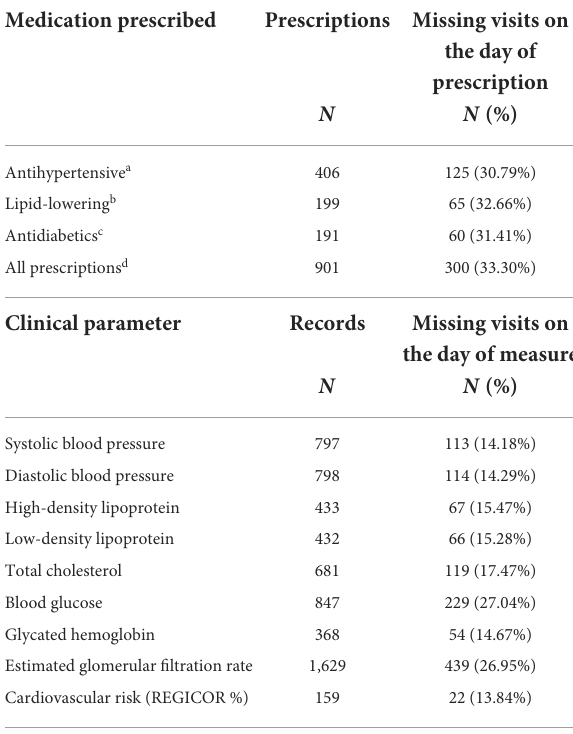
TABLE 4 Data availability of visits the day prescription s were issued and clinical parameters were measured.